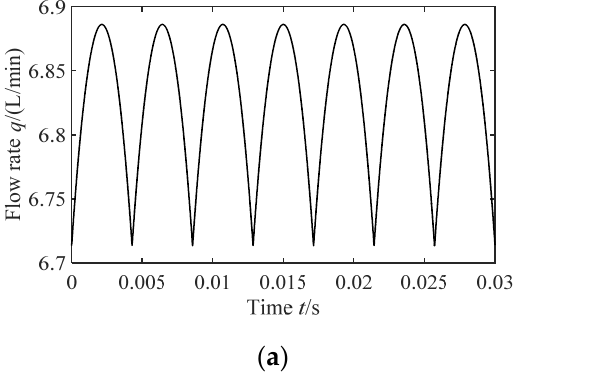
Figure 8. Flow pulsation excitation (flow velocity is 2 m/s). ( a ) Pulsation curve in time domain. ( b ) Pulsation curve in frequency domain.